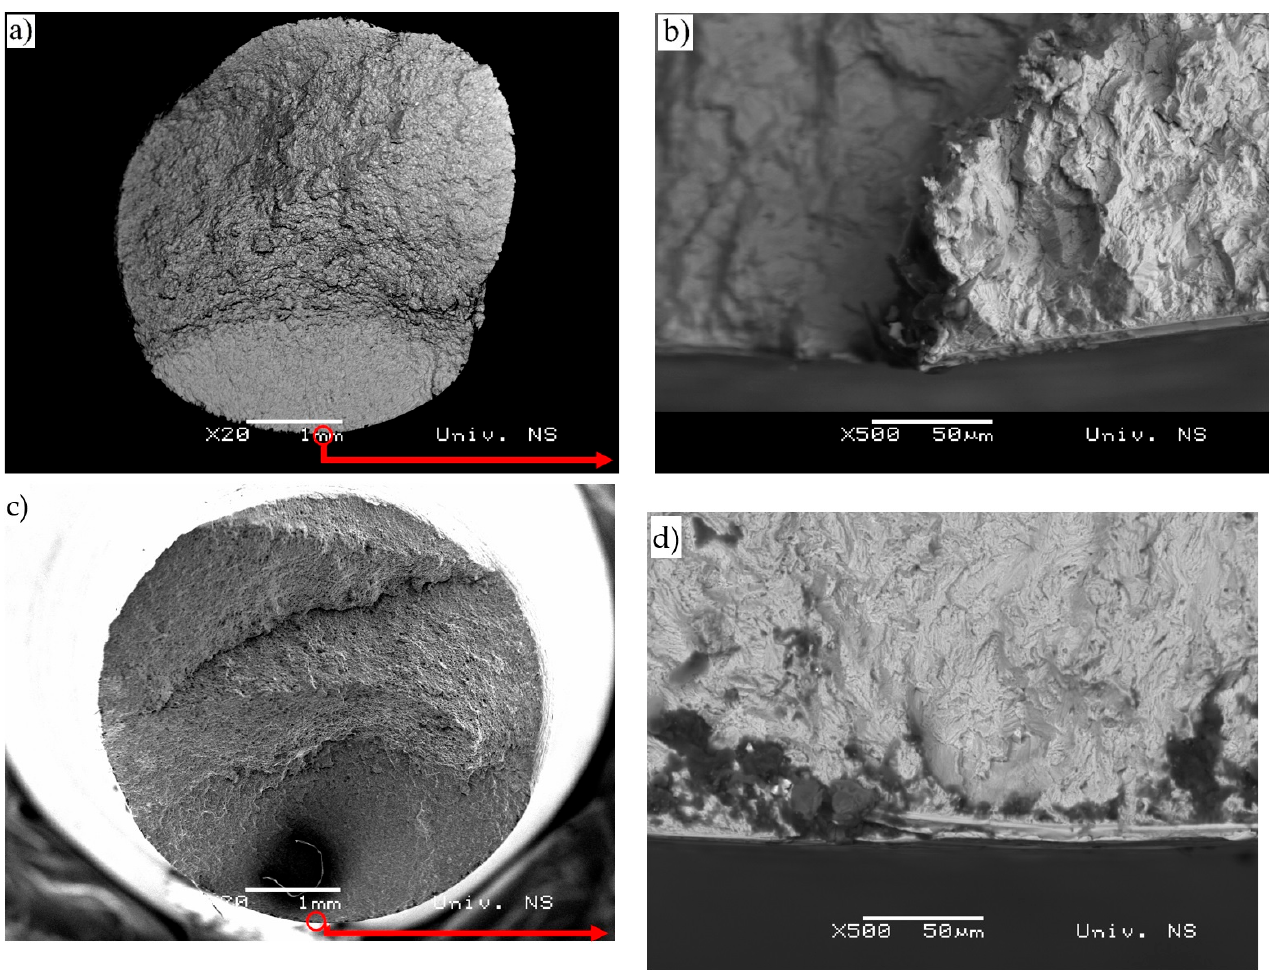
Figure 9. S235JRC+C and C15E+C steel alloys: macro images, inclusions and crack sites: ( a ) S235JRC+C: Macro image-specimen fracture surface, ( b ) Inclusions in undersurface area and crack site, ( c ) C15E+C: Macro image-specimen fracture surface and ( d ) Inclusions in undersurface area and crack site.